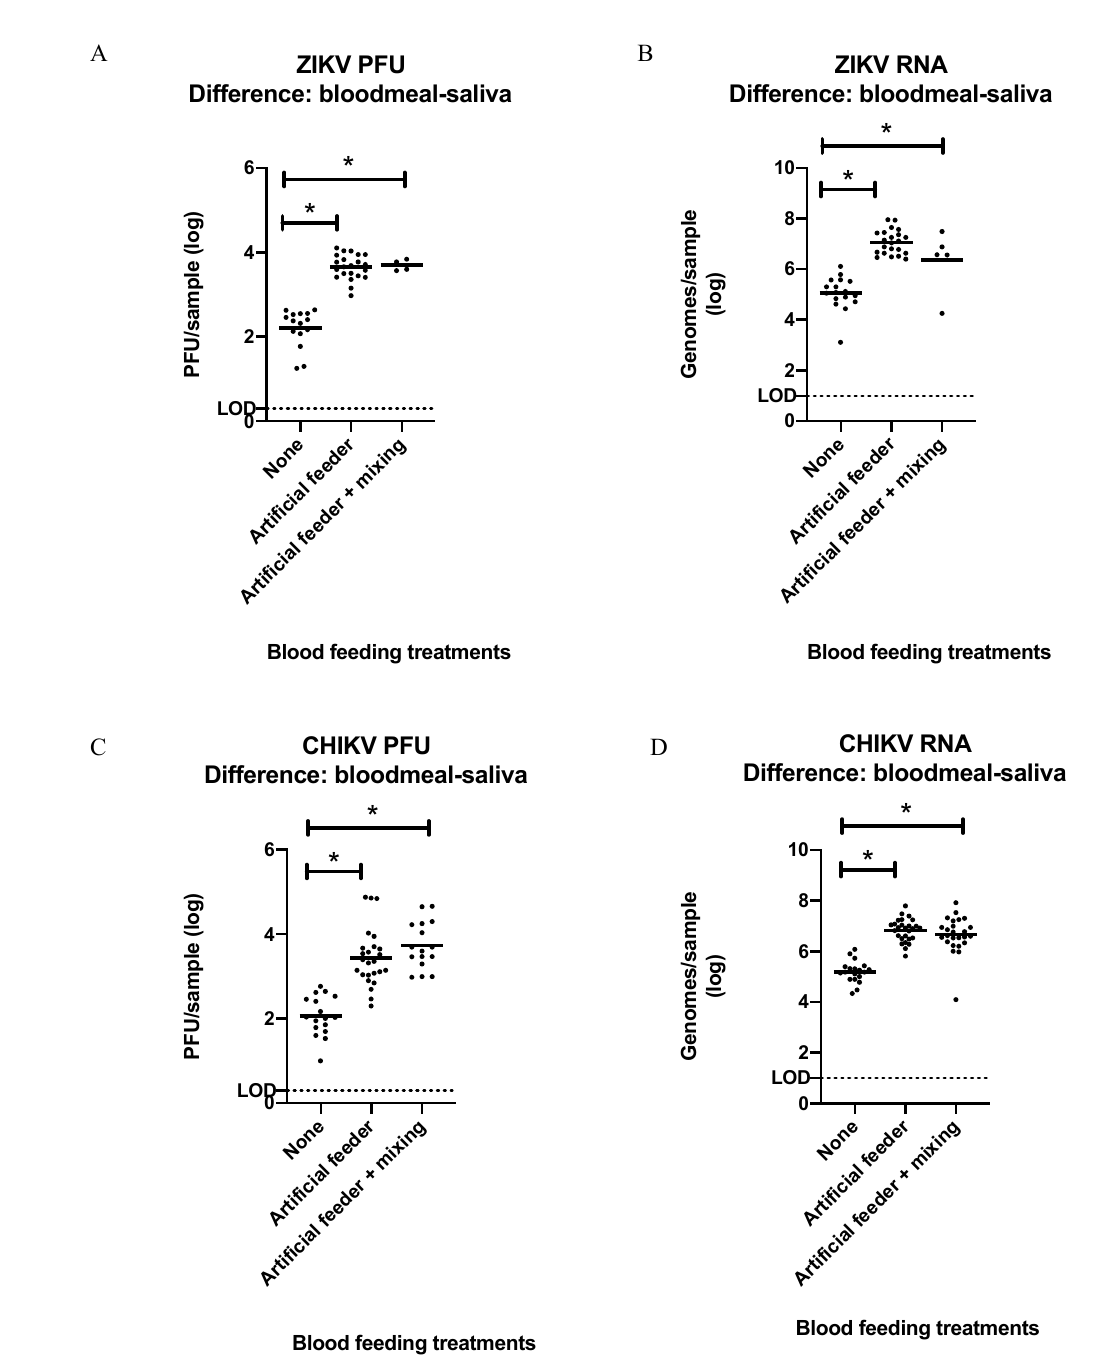
Figure 4. Log transformed difference between ZIKV and CHIKV detected in the bloodmeals and saliva of individual infected mosquitoes after they were given different blood feeding treatments. ( A ) Infectious ZIKV mean difference: None = 2.21, Artificial feeder = 3.65, Artificial feeder + mixing = 3.69. ( B ) ZIKV genome copies mean difference: none = 5.05, artificial feeder = 7.06, artificial feeder + mixing = 6.35. ( C ) Infectious CHIKV mean difference: none = 2.06, artificial feeder = 3.41, artificial feeder + mixing = 3.73. ( D ) CHIKV genome copies mean difference: none = 5.19, artificial feeder = 6.82, artificial feeder + mixing = 6.65. Graphs show both PFUs determined by plaque assay and RNA determined by qRT-PCR. Titer LOD= 2 PFU; genome copy LOD = 10 genomes. Means are horizontal bars (one-way ANOVA and post hoc Tukey test; * p ≤ 0.05).